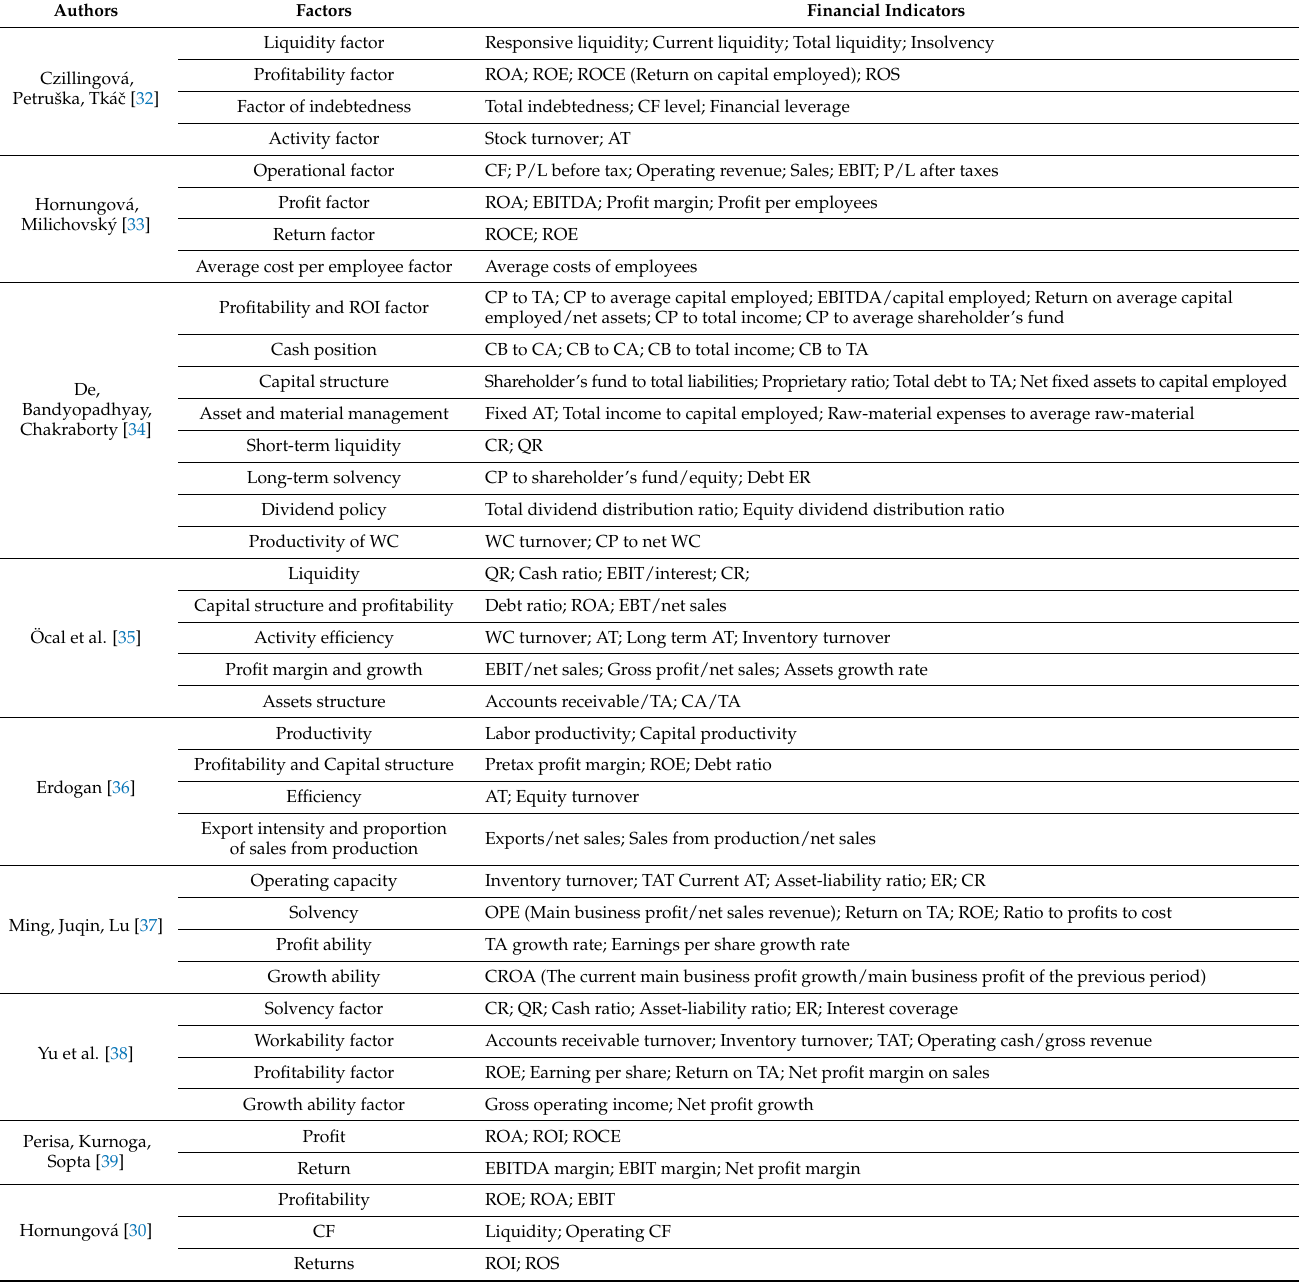
Table 1. Financial indicators used in the existing